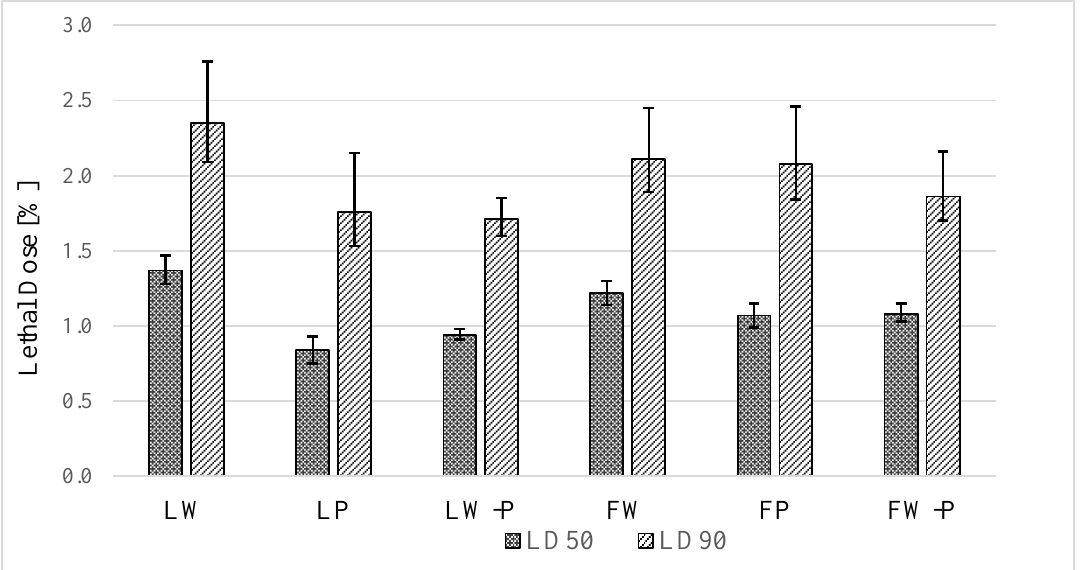
Figure 2. “Lethal dose with 95% CL of six types of A. conyzoides essential oils against Ae. aegypti . LW: Leaf white, LP: Leaf purple, LW-P: Leaf white-purple, FW: Flower white, FP: Flower purple and FW-P: Flower, white-purple.